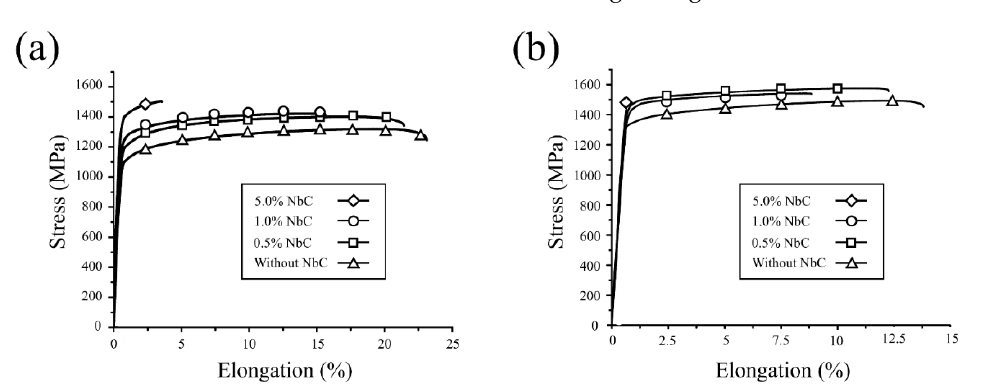
Figure 10. Room temperature tensile stress-strain curves ( a ) STA specimens and ( b ) DA specimens. Table 7. Tensile properties of specimens in this